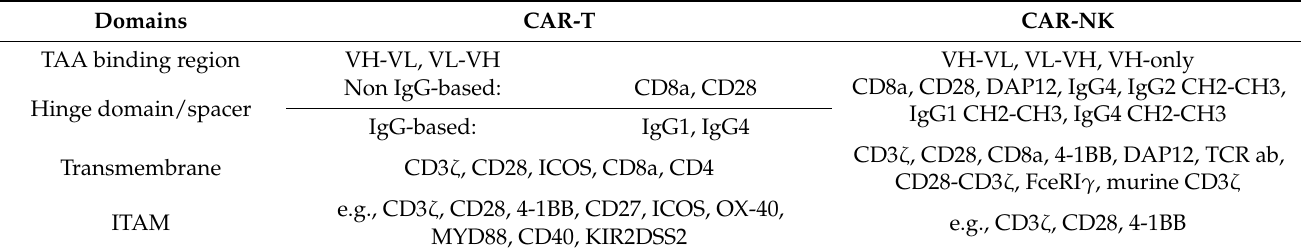
Figure 1. Schematic view of TCR and CAR molecules. ( A ) TCR (orange) on T cell is composed of α and β chains and binds to HLA (pink)-Ag (green) complex on target cell. CD3 (blue) has ε , ζ , γ , and δ chains. It serves as a co-receptor of TCR. ( B ) CAR is composed of the extracellular TAA binding region (orange), hinge or spacer region (green), transmembrane domains (blue), and the intracellular ITAM region (red) which is responsible for activating the cell once TAA binding region senses its target molecules. ITAM can be corresponding domains from CD3 ζ or Fc ε RI γ . Detailed information can be found in Table 1. ( C ) CAR binds to target protein (green) on cell surface to trigger downstream activation. Noted that, neither HLA nor CD3 is required here. Table 1. Comparison of CAR molecules between CAR-T and CAR-NK.